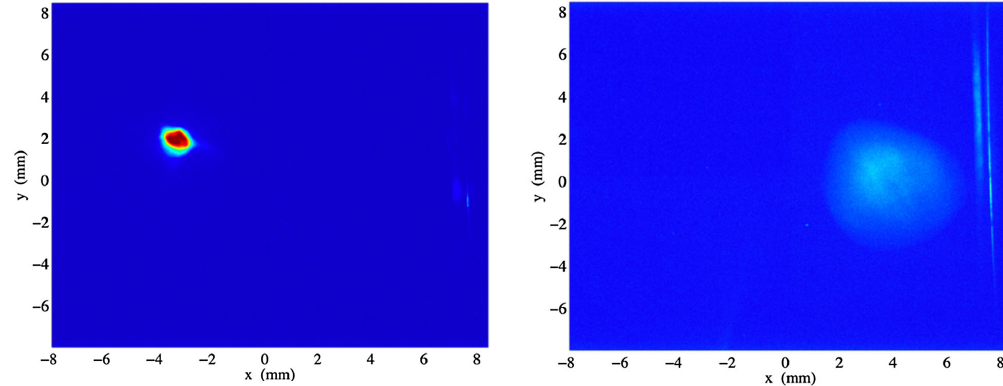
FIG. 7. Measured beam sizes for 40 pC bunches at zero crossing A (left) and B (right). The larger size at zero crossing B indicates that the beam was being bunched.